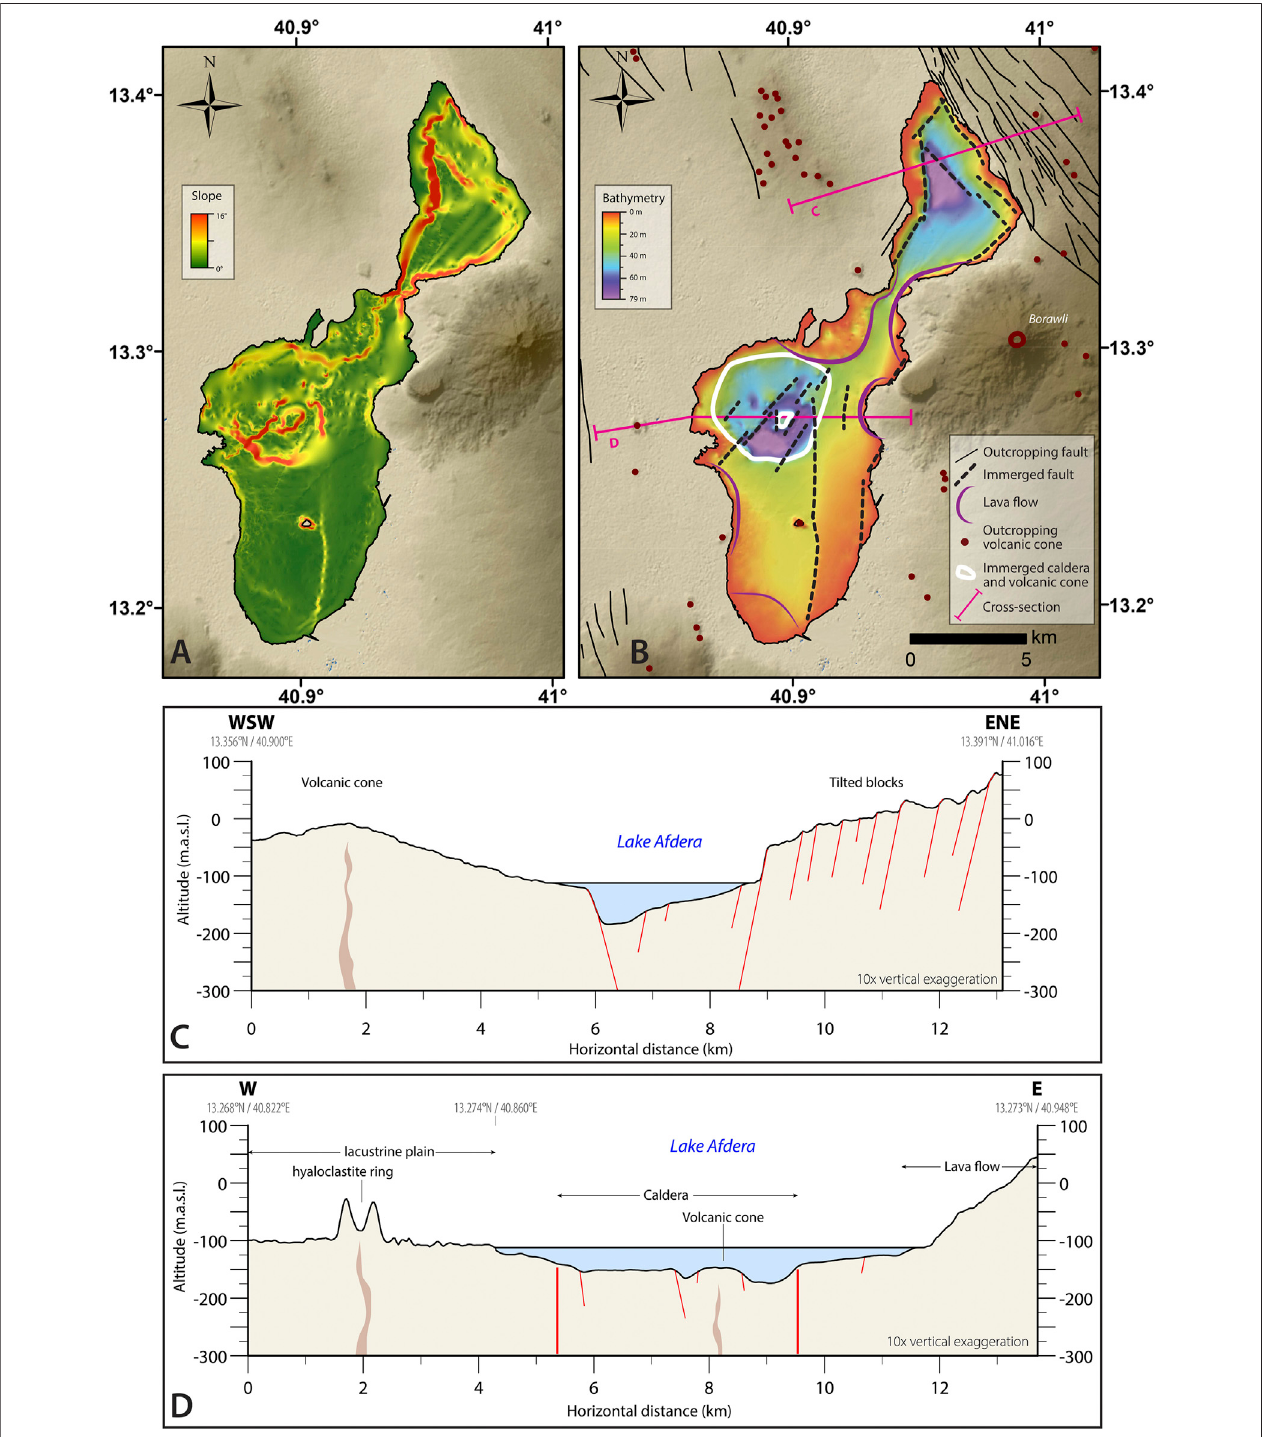
FIGURE 6 | Interpretation of the lake morphology. Slope map (A) allows to identify several faults as well as a volcanic edi fi ce in the lake (B) . (C,D) show cross- sections of the northern and southern basin. The northern basin shows a graben morphology while the southern basin indicates a faulted caldera with a nested volcanic cone.